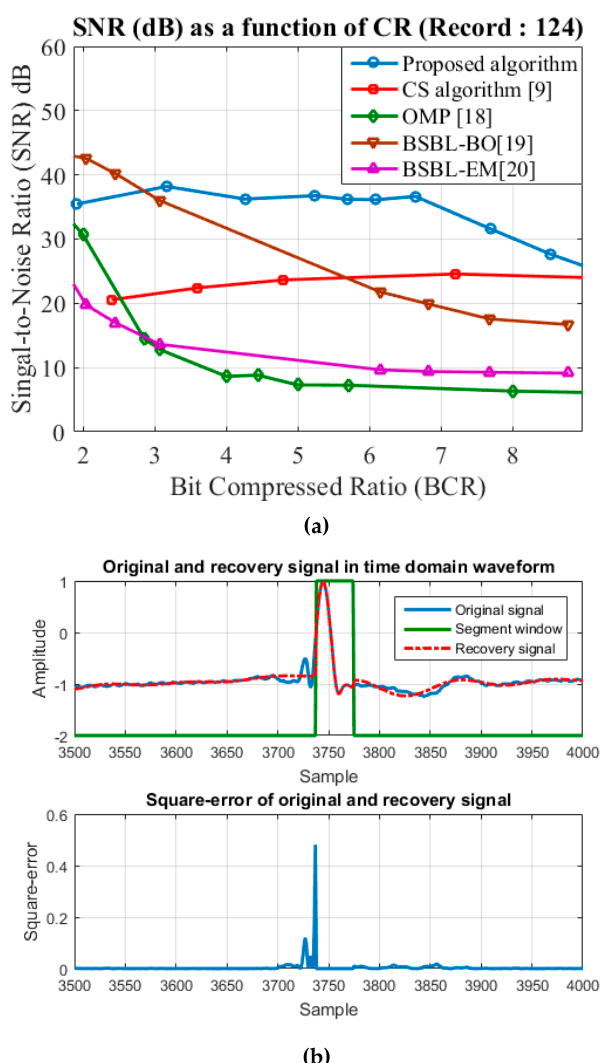
Figure 6. Example simulation using record 124: ( a ) comparison of SNR values obtained using different algorithms; ( b ) squared segment window offset error between the original and the recovery signal.